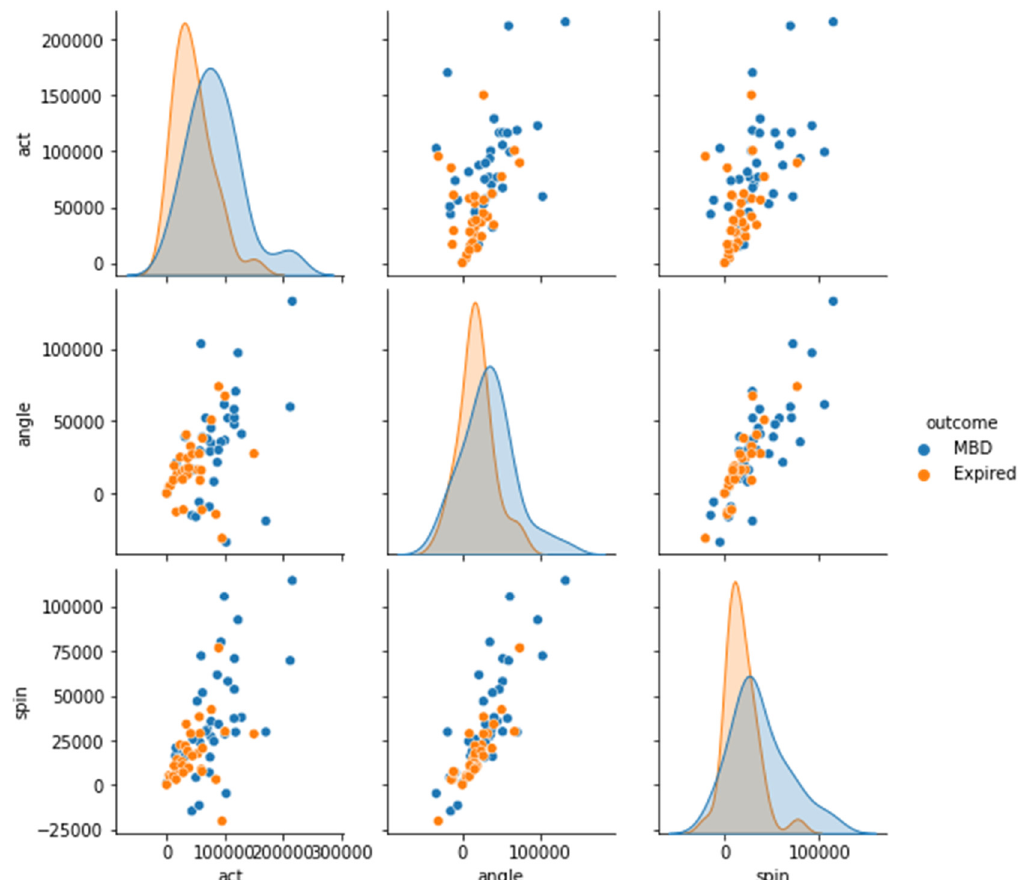
Figure 11. Differential representation between the ACT, angle, and spin at 48 hours in order see the relationship between two variables (MBD and expire).